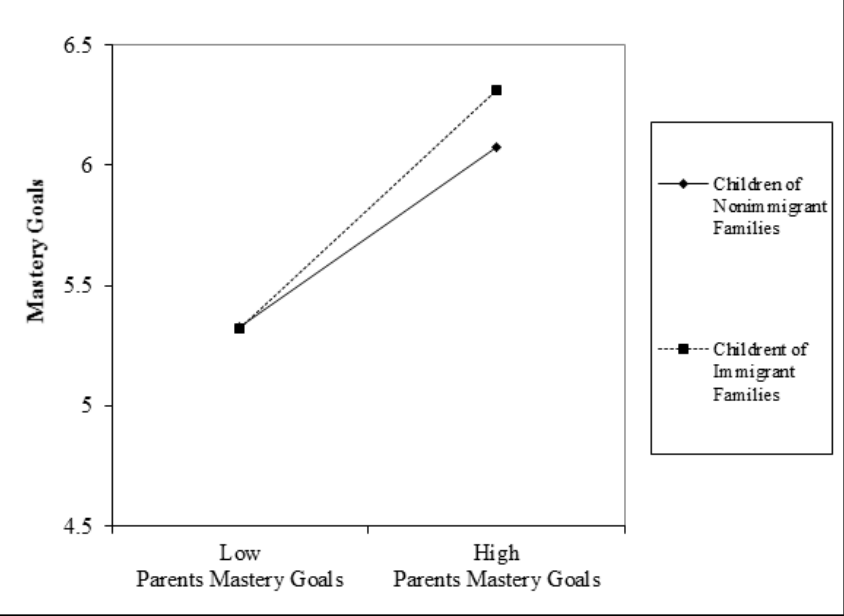
Figure 3 . Students’ own mastery goals as a function of immigration groups and parents’ mastery